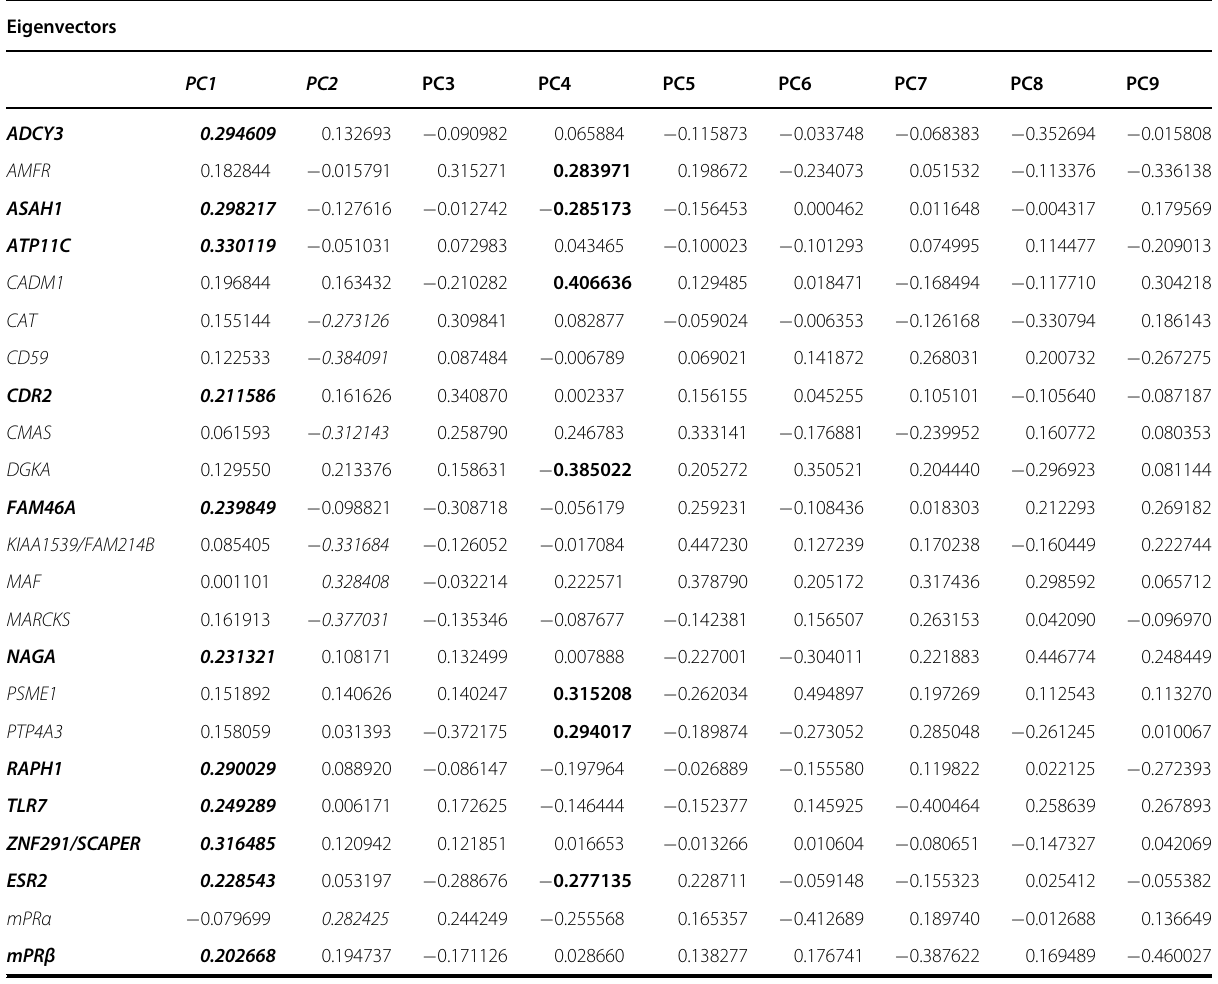
Table 4 Loadings of transcripts on principal components in pregnant